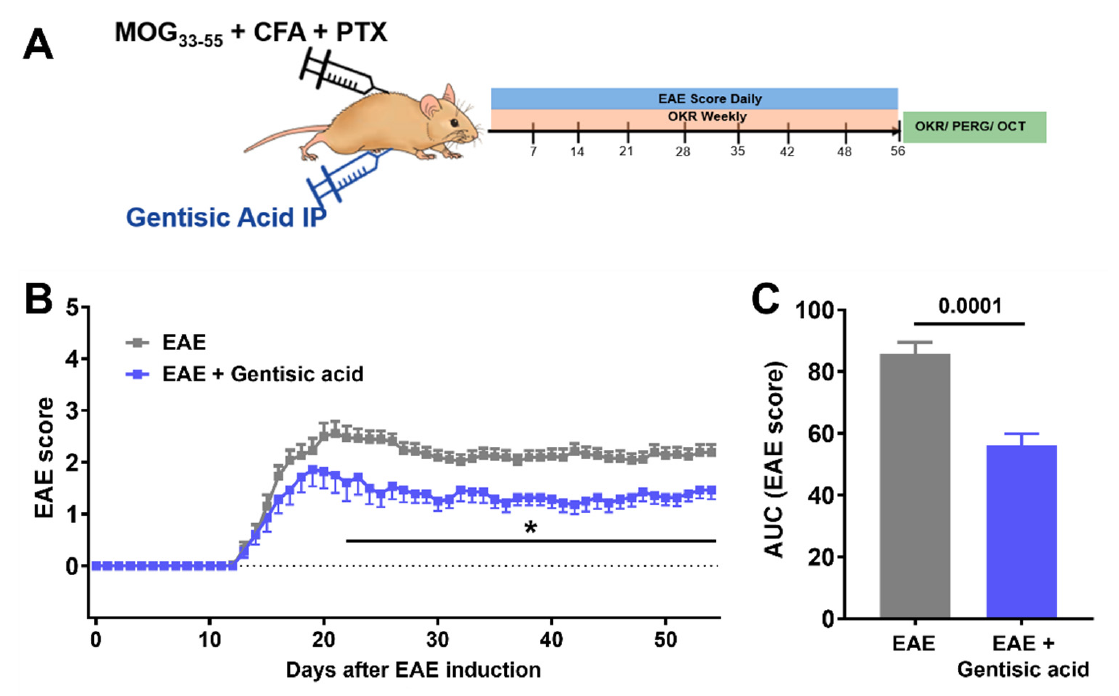
Figure 3. Systemic gentisic acid (GA) administration reduces clinical severity in MOG-induced EAE: ( A ) Overview of animal study design including EAE induction in 52 female C57BL6/J mice and in vivo readouts. Twenty-six EAE mice received weekly intraperitoneal (ip) administration of 50 mg/kg GA. All animals underwent daily EAE scoring, weekly assessment of visual acuity, and pattern ERG recordings and OCT imaging 56 days after EAE induction. ( B ) Untreated EAE mice (grey = EAE) displayed a moderate course of motor sensory impairment over time. Systemic GA admin- istration in EAE animals (blue = EAE + GA) mitigated motor-sensory deficits and resulted in a sig- nificantly milder disease progression. Mean scores per day with SEM are given and * indicates p < 0.05 in EAE vs. EAE + gentisic acid treatments. ( C ) Analysis of area under curve (AUC), as the sum